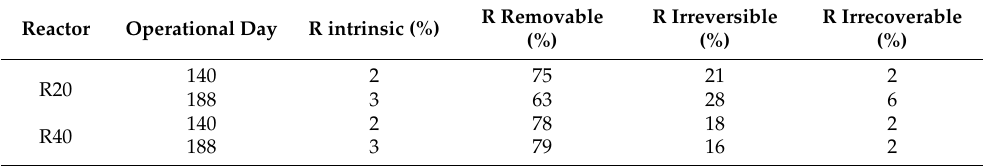
Table 1. Individual resistances for the R20 and R40 reactors at operational days 140 and